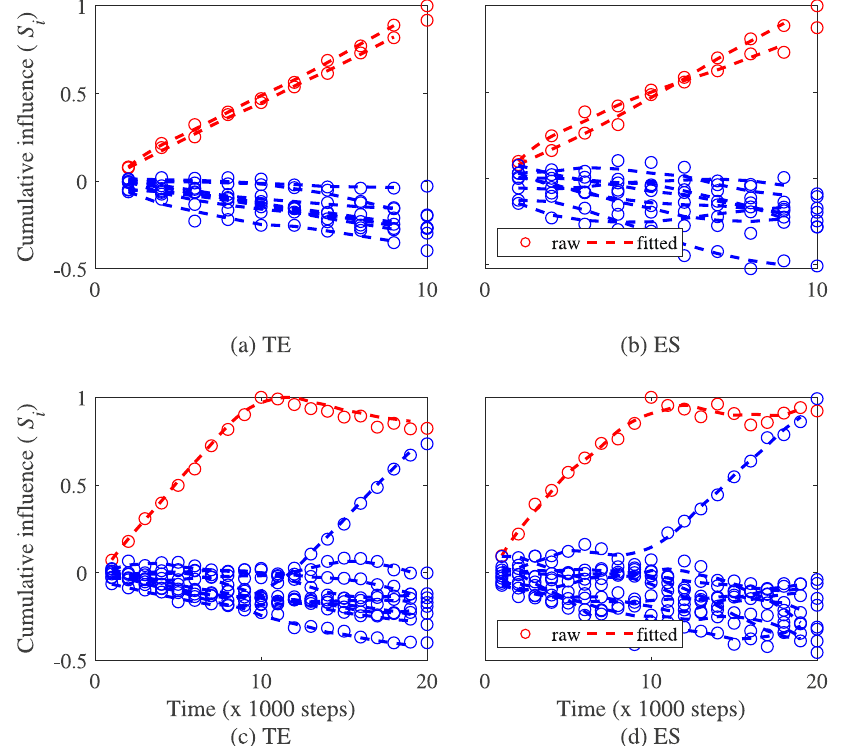
Figure 8. Illustration of the method on Vicsek model with N = 10 particles with no switching event ( a ) and ( b ) and a single switching leadership event ( c ) and ( d ). In ( a ) and ( b ), the time trace of the cumulative influence index for leaders is increasing while decreasing for the followers. In ( c ) and ( d ), the time trace of the leadership index of the particles switching from either leader to follower (red) or follower to leader (blue transition) showed a significant change in their monotonicity as time evolved. Note that the values of the cumulative influence ( S i ) are normalized between − 1 and 1. Model parameter are N = 10, K = 1, v = 0.05, and η = 0.2. Note that K = 1 indicates that in average each particle interacts with a single